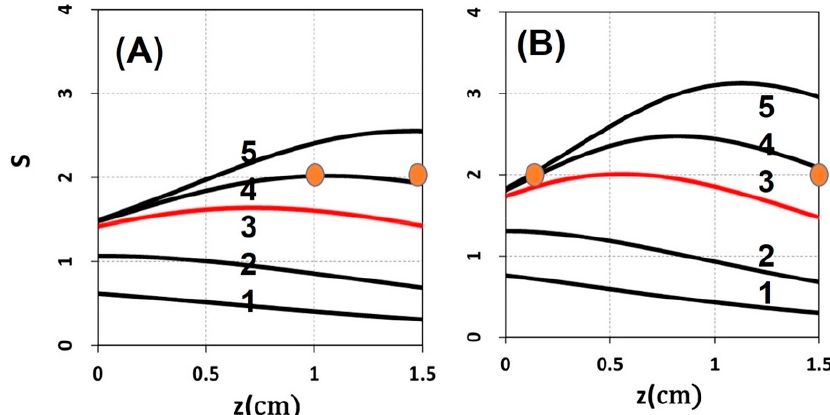
Figure 7. S versus light intensity (I 0 ), for t = 100 s (red curve) and 200 s (green curve), and z = 0.5 cm, D = 1.0 cm, C 0 = 2 mM.